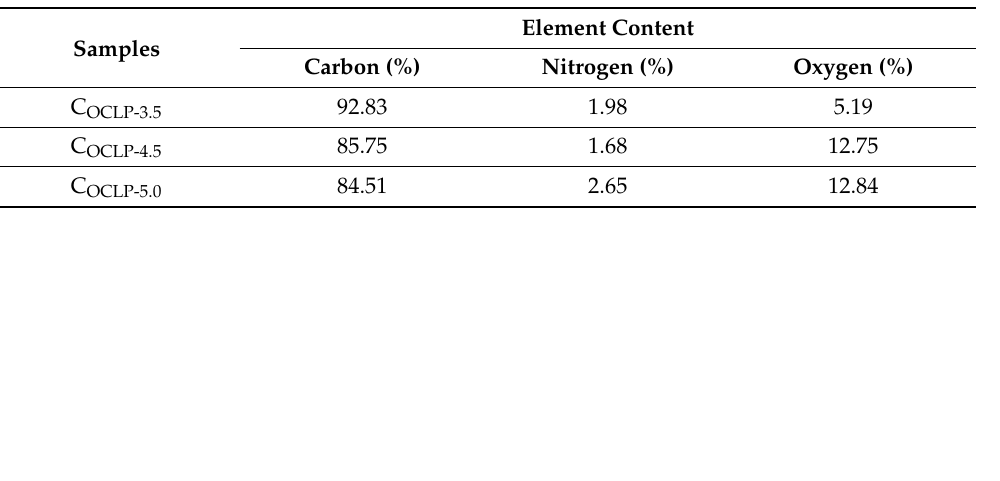
Table 2. Surface element content of the C OCLPs